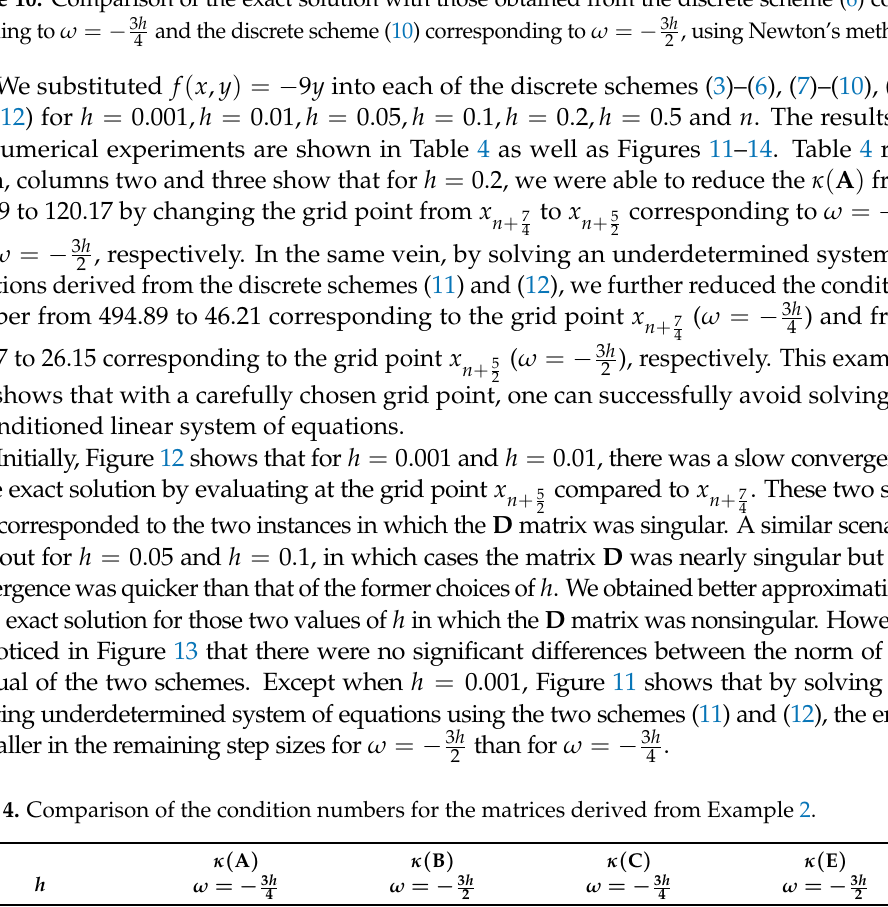
3 h , using Newton’s method. 3 h using Newton’s 2 − 2 −